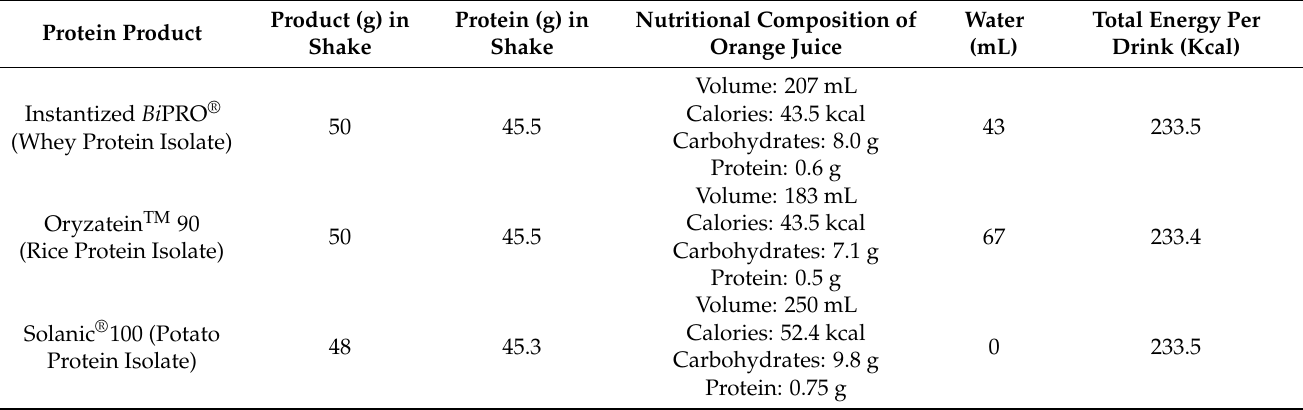
Table 1. Composition of protein